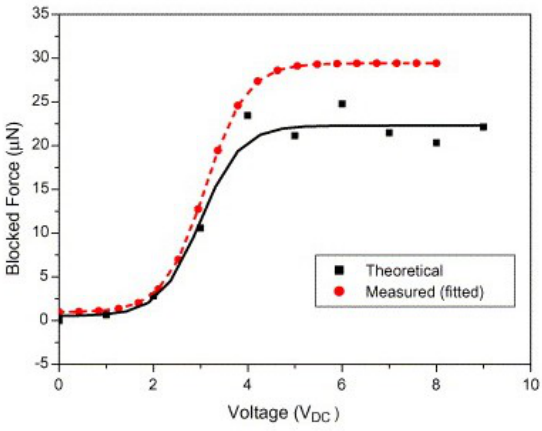
Figure 11. Comparison of measured and calculated blocked forces on DC electric field [53].